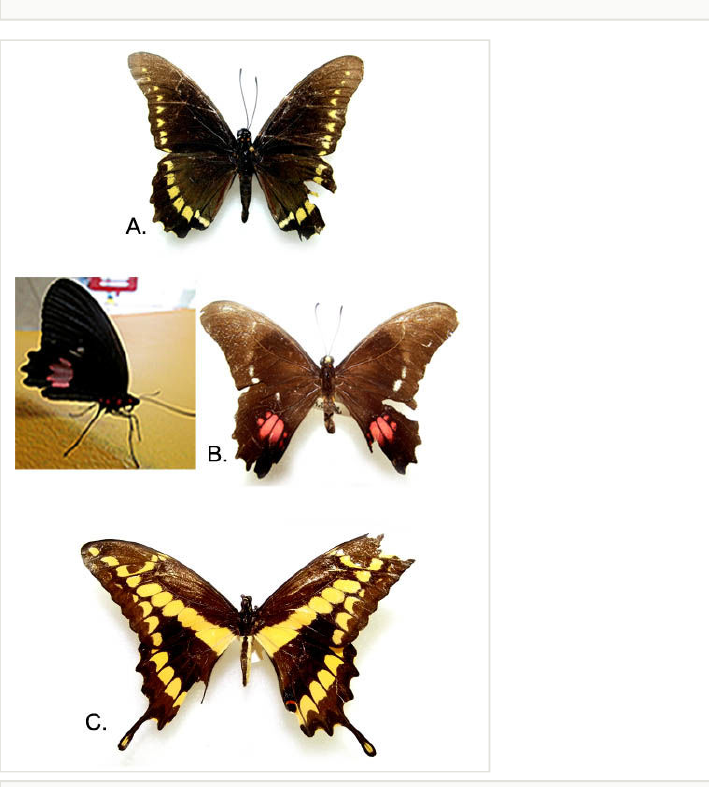
Figure 1. Percent representation of the abundance per Lepidoptera family.